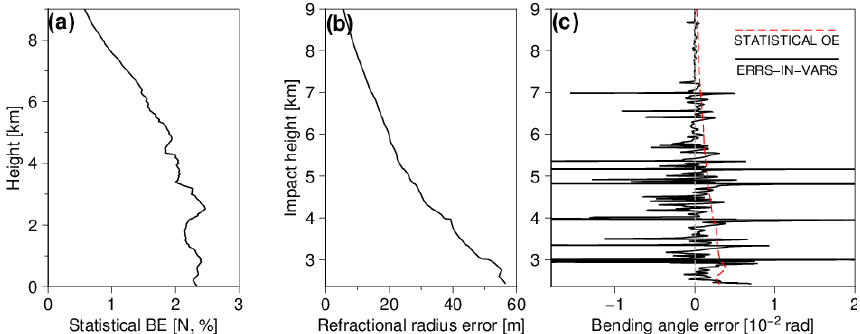
Figure 5. Errors involved in the test with a synthetic sounding: (a) statistical estimate of model error in the refractivity at the time and location of the sounding; (b) model error in the refractional radius resulting from that in the refractivity; (c) statistical error estimate of bending angle observation (dashed red line) and the bending angle error due to the errors-in-variables problem (solid black), which is the modeling error of the synthetic bending angle stemming from the model error in the refractivity.